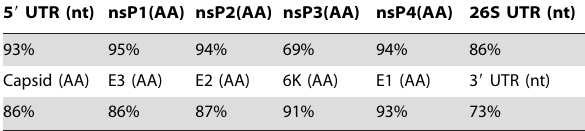
Table 5. Identity percentage between the IAB TrD and 68U201